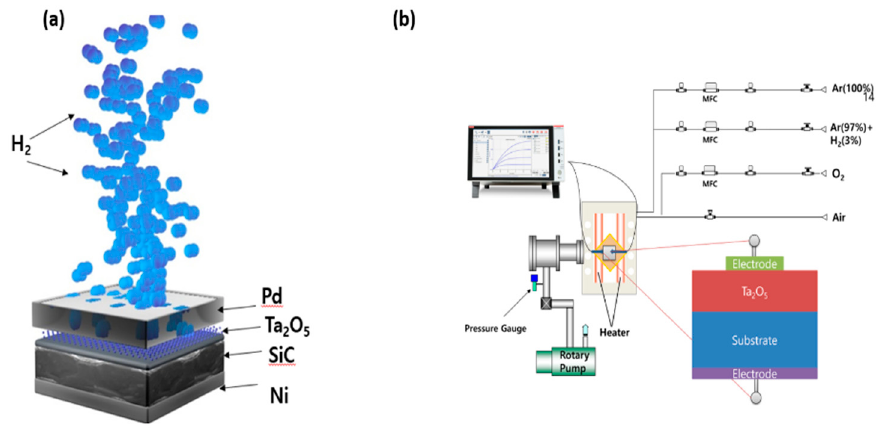
Figure 2. Schematic diagrams of ( a ) the Pd/Ta 2 O 5 /SiC H 2 sensor, and ( b ) the setup for the electrical measurements.